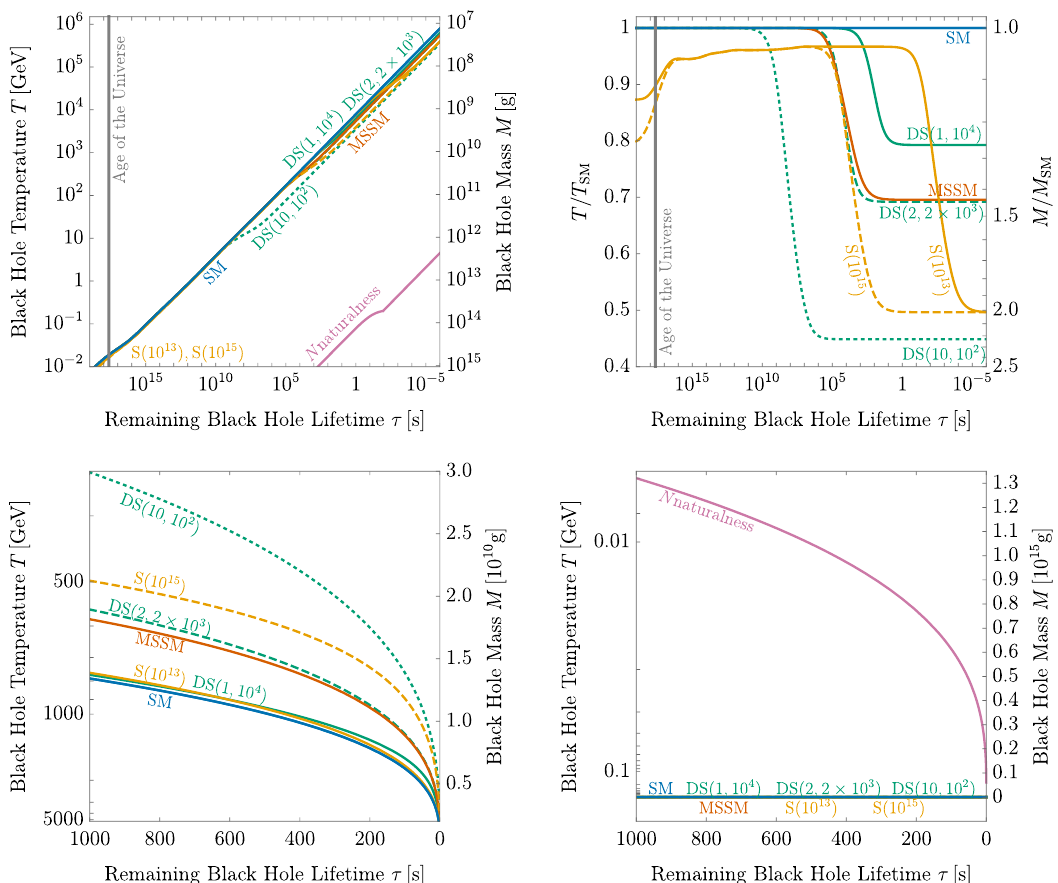
Figure 3 . Top left: the black hole temperature and mass as a function of the remaining black hole life time, τ , for our benchmark models. Top right: the ratio of the black hole temperature to the SM expectation at the same τ for our benchmark models. Bottom row: the black hole temperature and mass on a linear scale, excluding (bottom left) and including (bottom right) the N naturalness benchmark